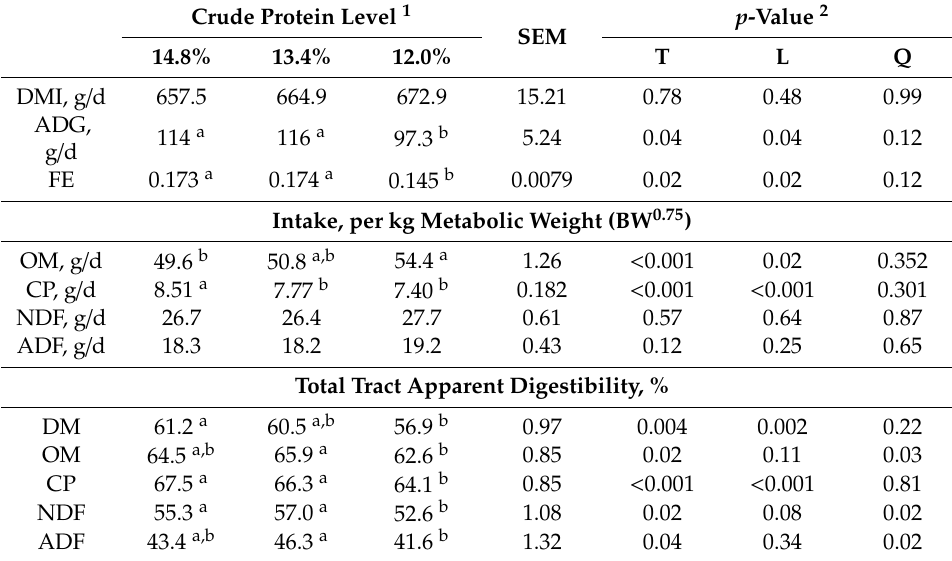
Table2. E ff ectsoflow-proteindietsondrymatterintake(DMI),averagedailygain(ADG),feede ffi ciency (FE), and apparent total-tract digestibility of nutrients in growing goat kids.